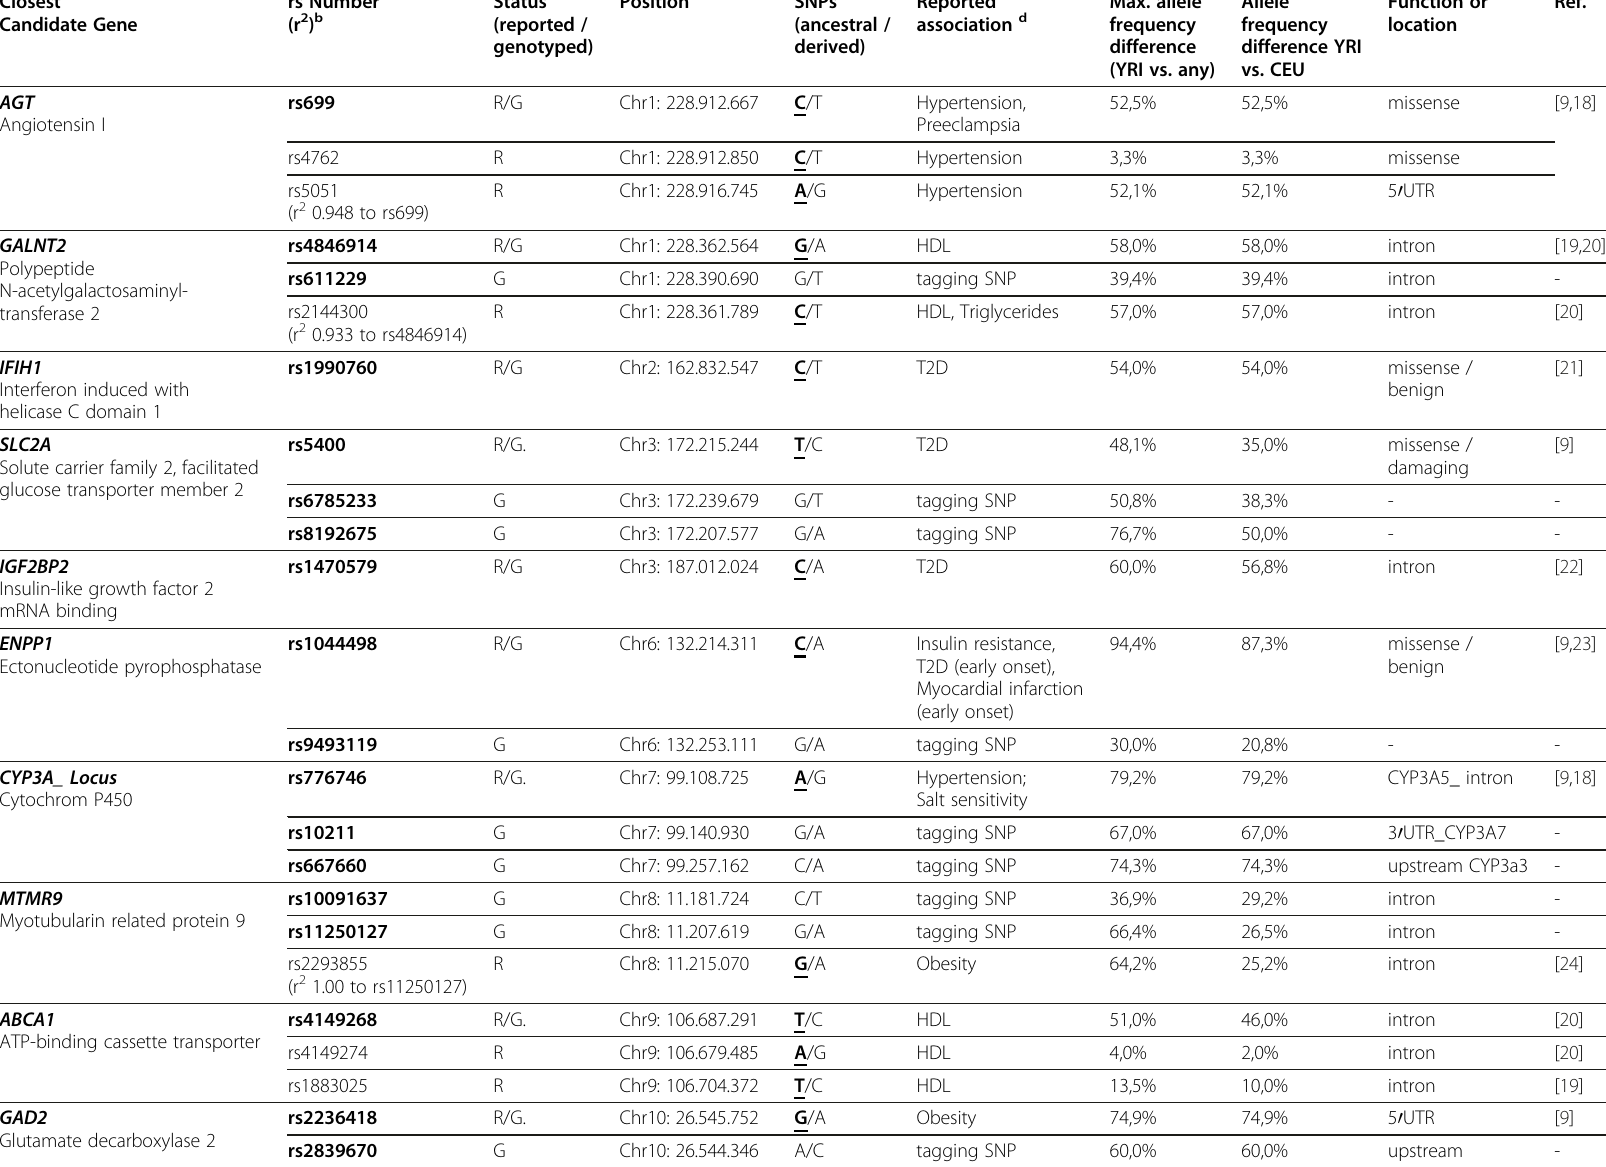
Table 1 Information about genes and SNPs selected for the SNP association study Closest Candidate